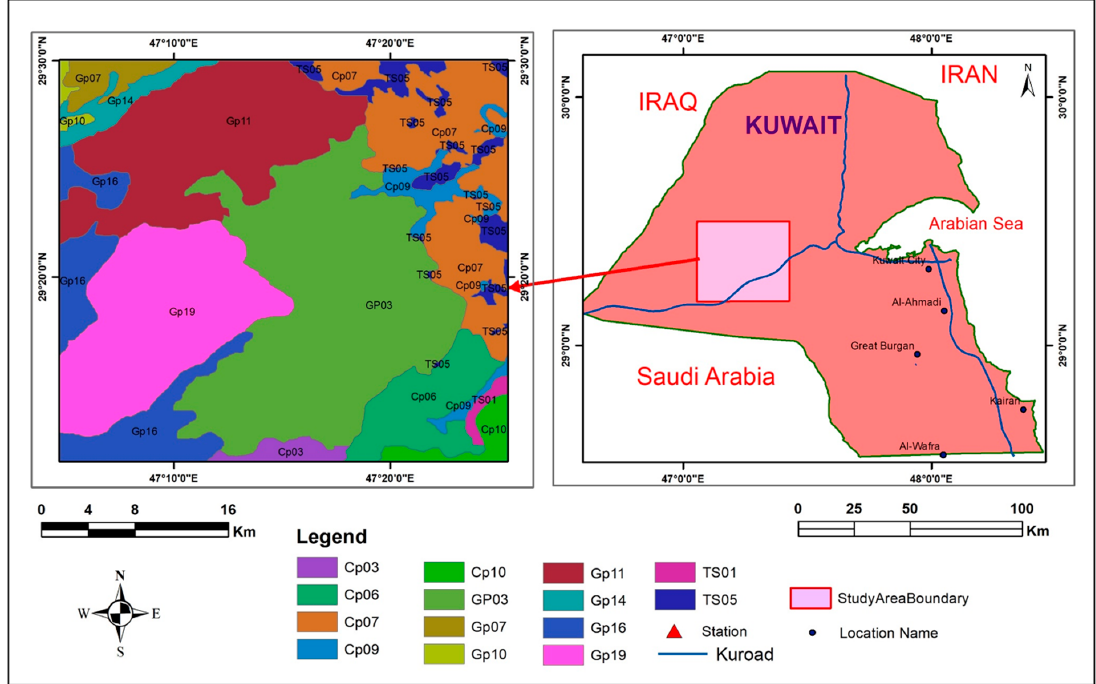
Figure 1. The test site of 36 km by × 36 km with 14 soil types showing six in situ stations. The work